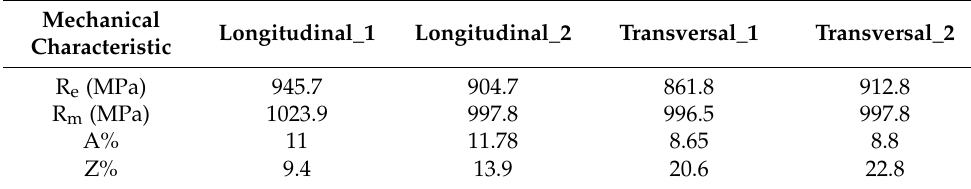
Table 3. Tensile test. Characterization CP1000 G10/10.